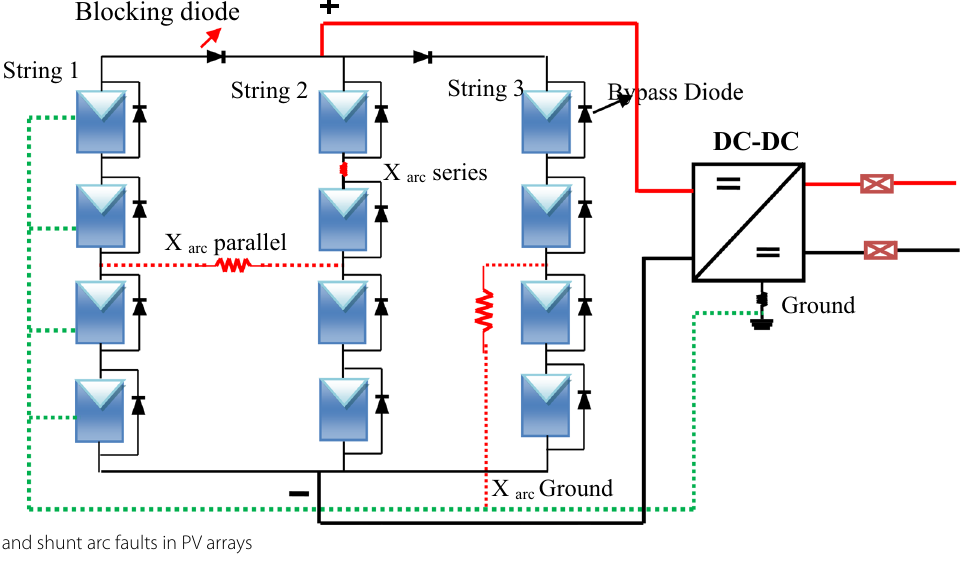
Fig. 8 Series and shunt arc faults in PV arrays